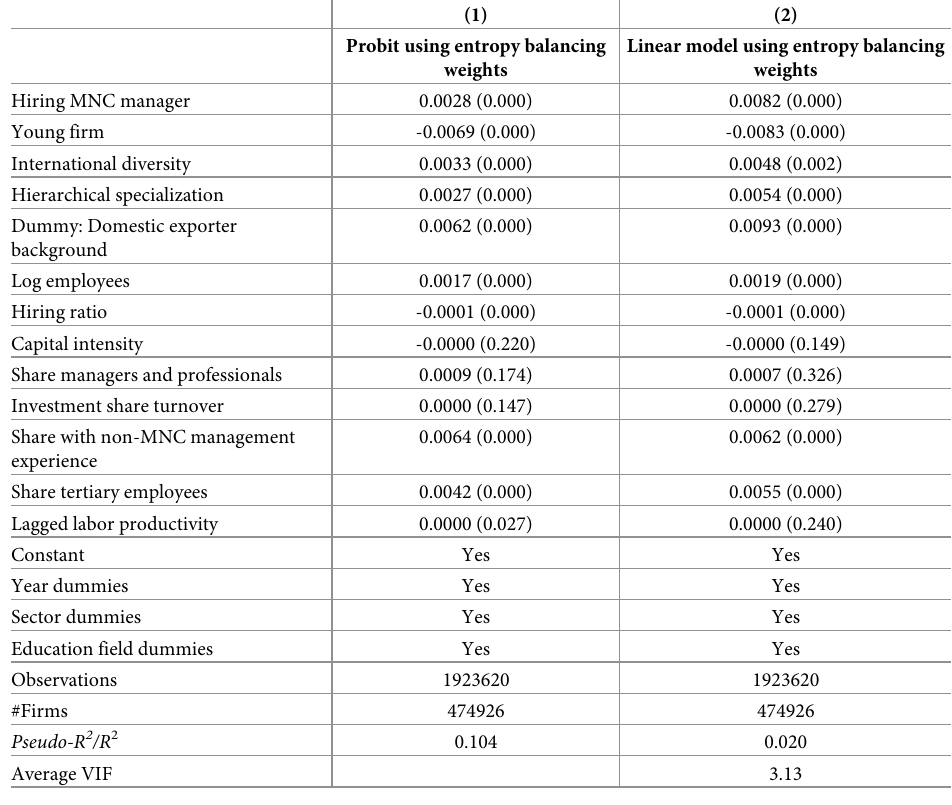
Table 3. Baseline probit regressions (marginal effects for probit; dependent var: Dummy: Exporter).